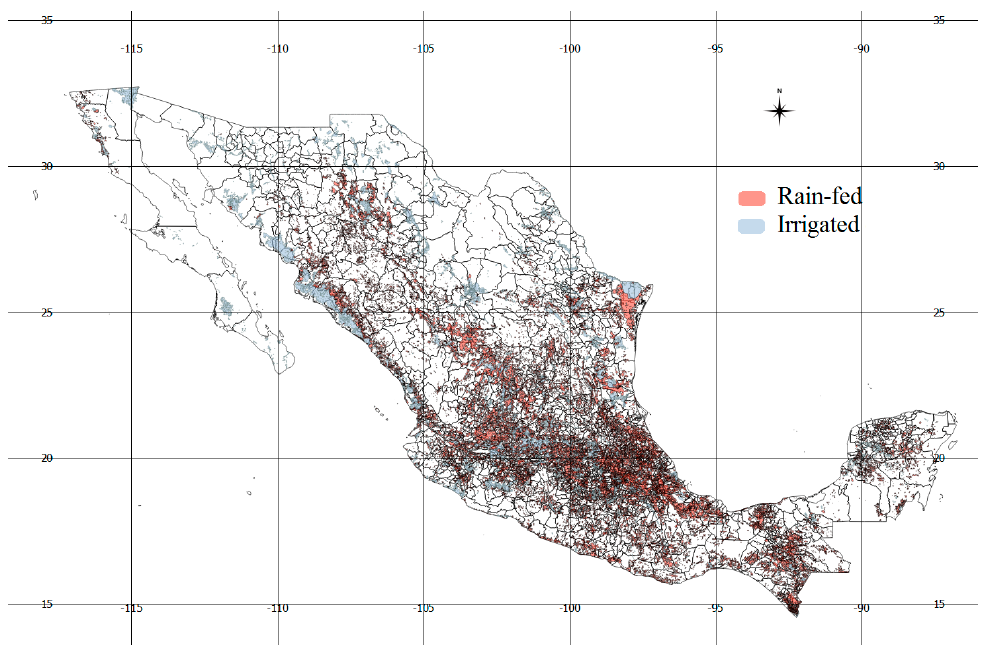
Figure 1. Study area with the locations of irrigated and rain-fed crops in Mexico.